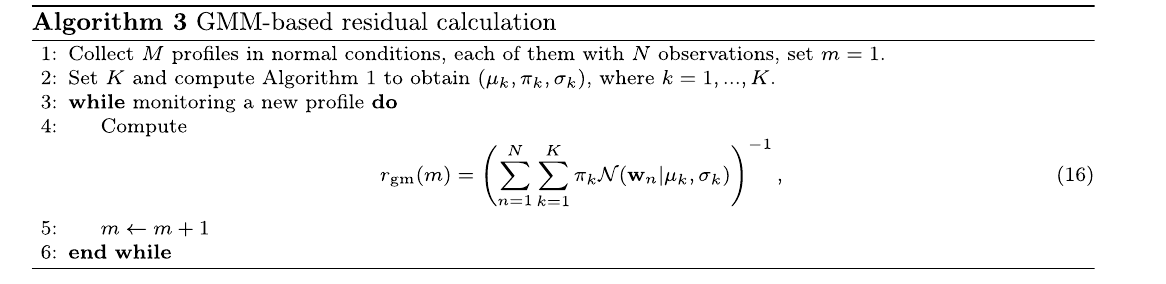
Algorithm 3 is proposed for the residual calculation r gm using GMM.